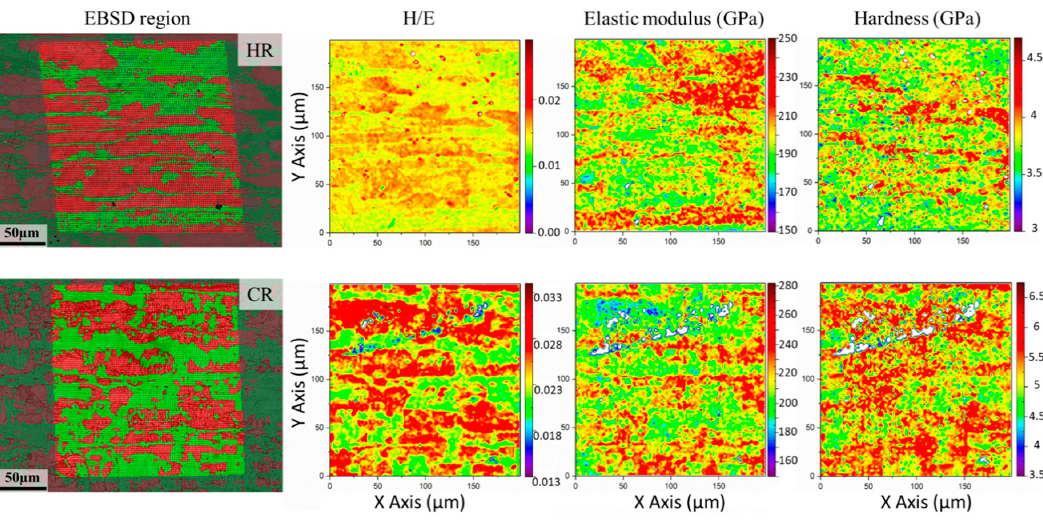
Figure 7. Electron backscatter di ff raction (EBSD) maps of indented surfaces and corresponding cartography maps of indicated region for HR and CR samples.